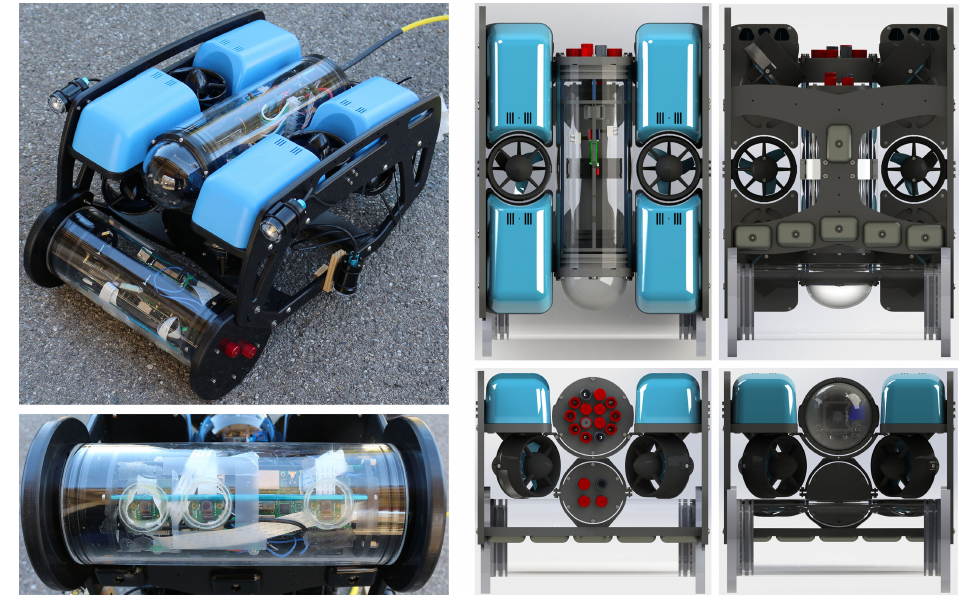
Figure 2. The built trifocal system integrated within a blueROV 2 (the front